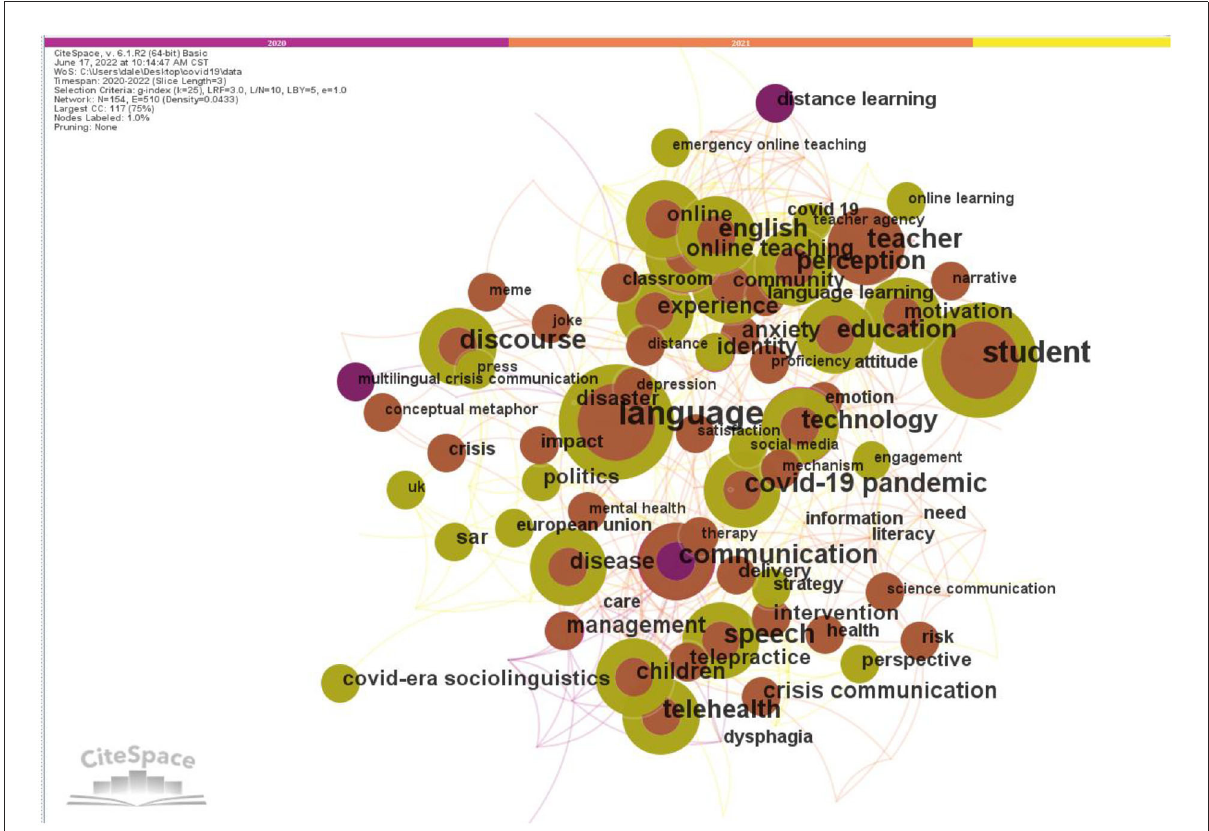
FIGURE3 Keyword co-occurrence network for documents of linguistic research on